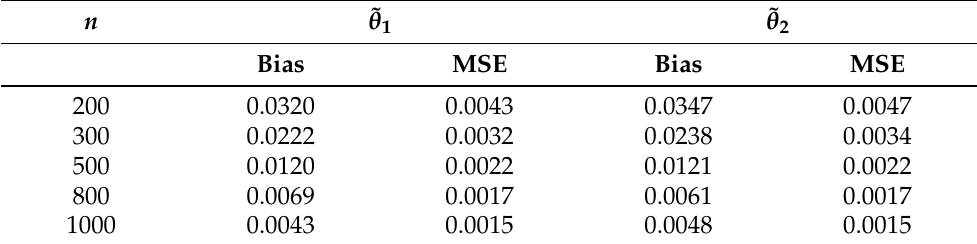
Table 6. The bias and MSEs of BEs for θ 1 = θ 2 =